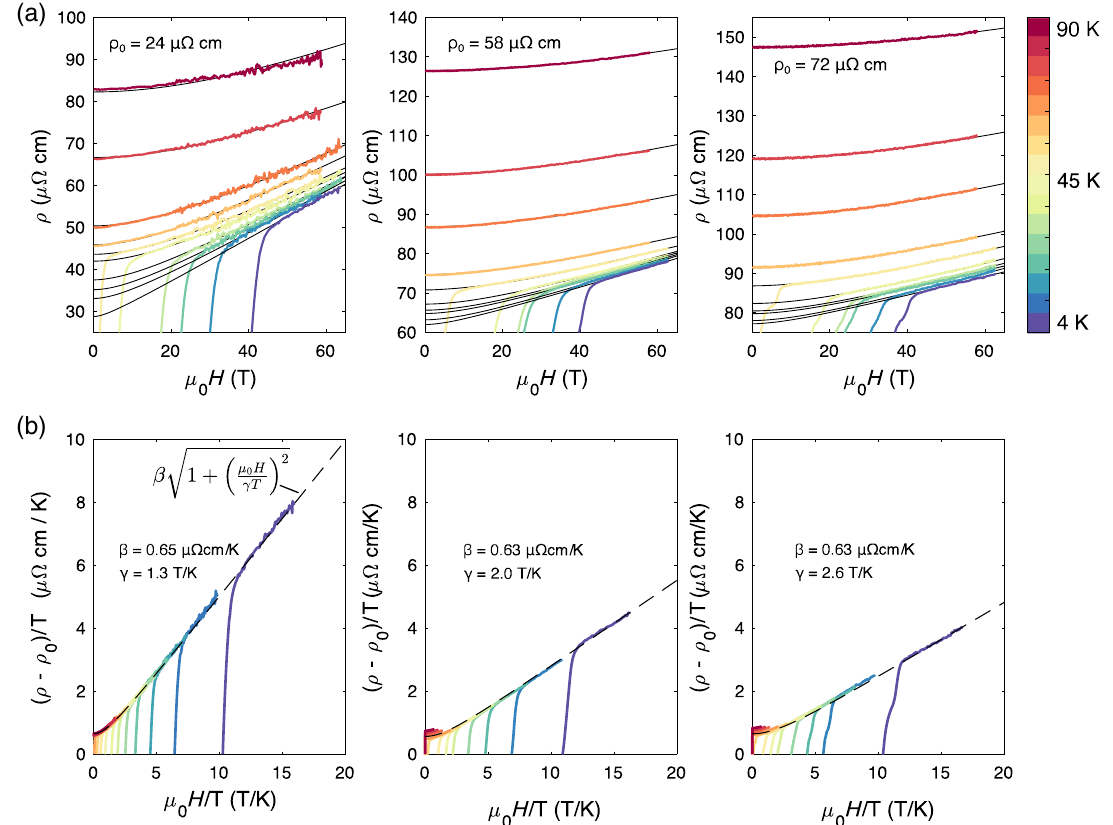
Þ P 0 2 with varying levels of disorder. (a) Samples . 81 . 31